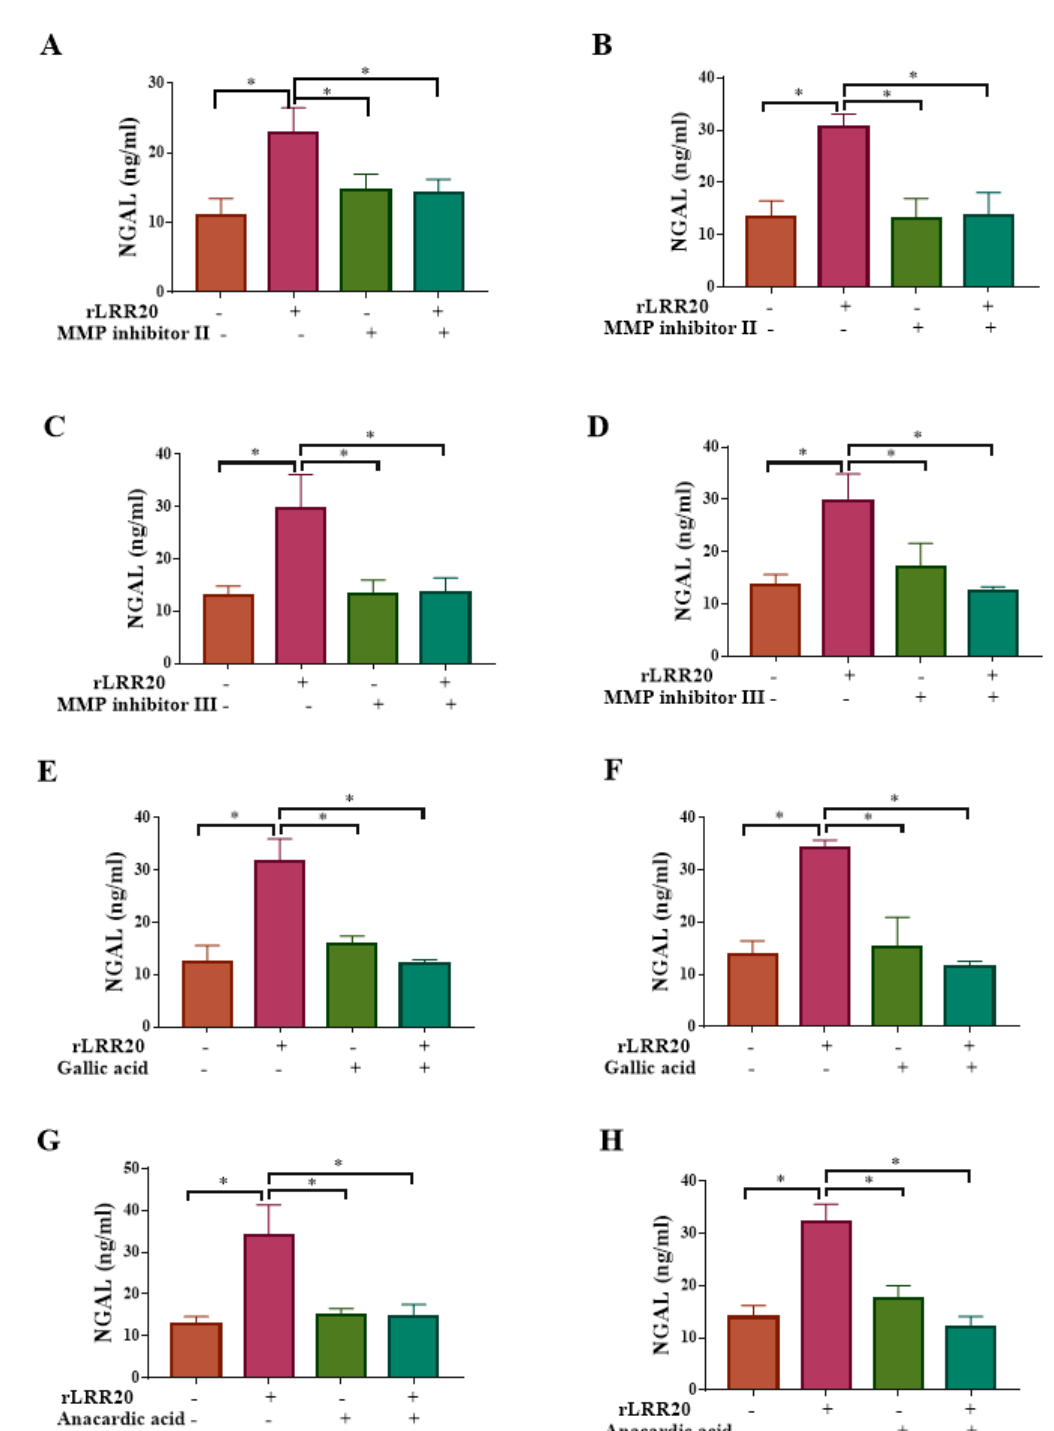
Figure 9. rLRR20 promotes the expression of NGAL by activating the NF- κ B pathway. rLRR20-induced upregulation of NGAL through the NF- κ B signaling pathway was demonstrated using various inhibitors. Effect of MMP inhibitor II, an MMP7 inhibitor, on the NGAL levels in HK2s ( A ) and hRPTECs ( B ). Effect of MMP inhibitor III, an MMP7 inhibitor, on the NGAL levels in HK2s ( C ) and hRPTECs ( D ). Effect of gallic acid on the NGAL levels in HK2s ( E ) and hRPTECs ( F ). Effect of anacardic acid, a NF- κ B:p65 inhibitor, on the NGAL levels in HK2s ( G ) and hRPTECs ( H ). Dimethyl sulfoxide (DMSO) was used as the control. * p < 0.05.